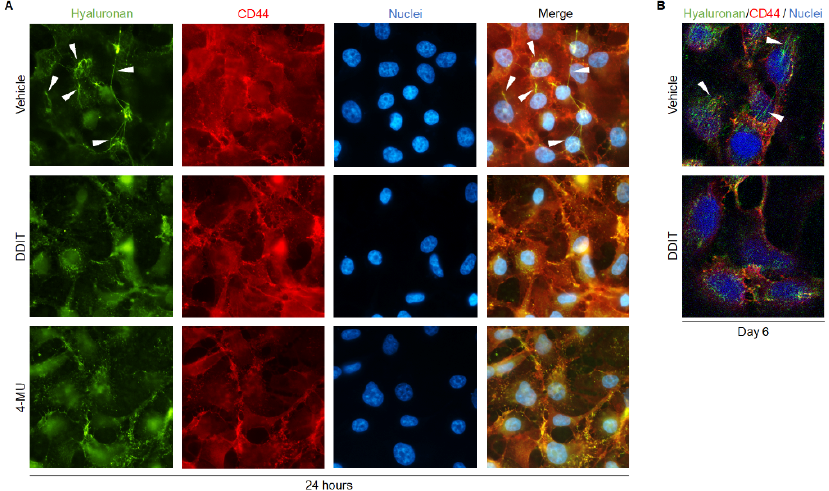
Figure 5. DDIT inhibits formation of hyaluronan cable-like structures. ( A ) Representative images of immunofluorescence staining for hyaluronan (green)/CD44 (red) in Hs578T cell cultures, 24 h after treatment with vehicle (0.04% DMSO), DDIT (80 µ M) or 4-MU (1 mM) in serum-free medium. ( B ) Confocal imaging of hyaluronan (green)/CD44 (red)-stained Hs578T breast cancer cells after treatment with vehicle or DDIT in 10% FBS, for 6 days. Nuclei were stained with DAPI (blue). Arrow heads indicate hyaluronan cable-like structures. The images were captured with a 63 ×